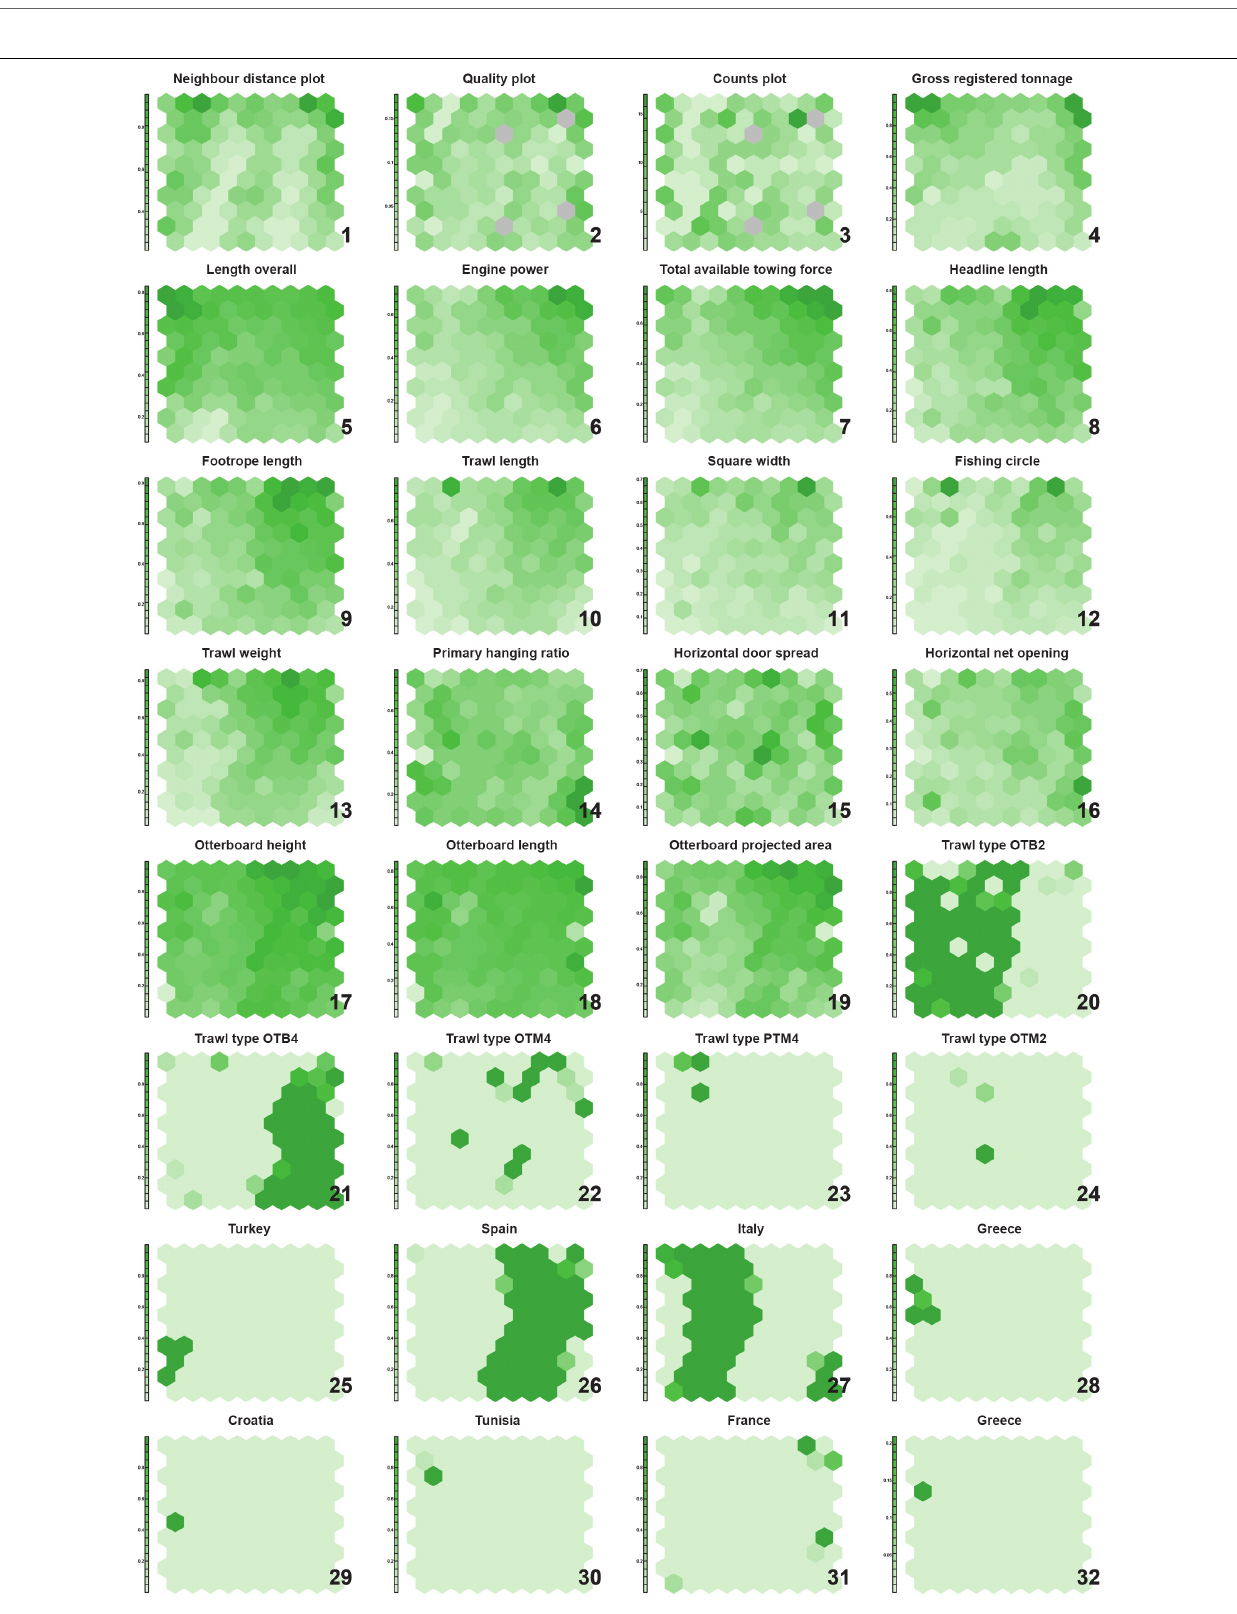
Frontiers in Marine Science |